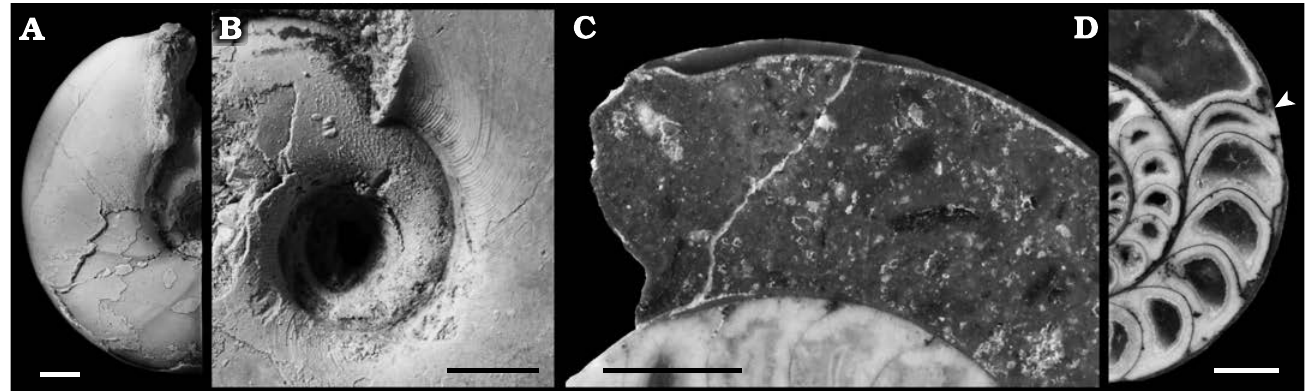
Fig. 4. Mature modifications recognised in tetragonitid ammonoid Tetragonites minimus Shigeta, 1989, from the Yezo Group in the Haboro, Kotanbetsu, Tappu, Nakagawa, Soya, and Yubari areas, Hokkaido, Japan. A , B . Changes in the shape of the body chamber: modification appeared at venter ( A , MCM-W1591) and umbilicus ( B , MCM-W1556). C . Shell thickening in the aperture, MCM-W1560. D . Septal crowding and increase in septal thickness, MCM-W1565; arrowhead indicates the last septum. Scale bars 2